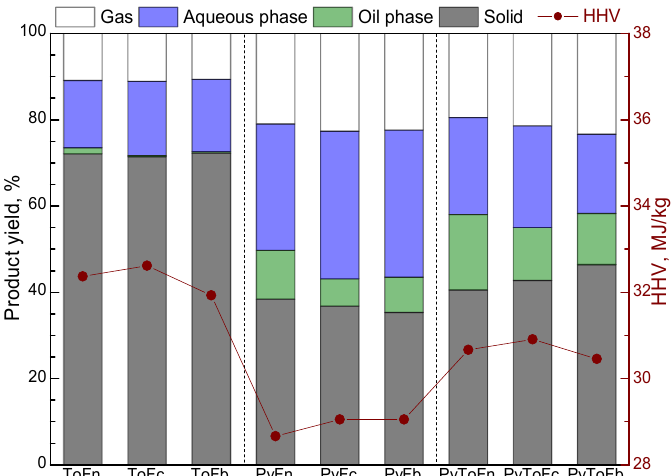
Figure 2. Product yield (±5% associated error) and high heating value (HHV) of solid residues from thermal processing of fir needles, cones and bark by torrefaction and/or pyrolysis. In addition to the product yield, energy aspects should be also considered when deciding on the efficiency of thermal processes. The high heating values of the solid materials were calculated based on the ultimate analysis and are presented in Table 1. Table 1. Proximate ( ± 3% associated error) and ultimate ( ± 5% associated error) analysis (wt%, moisture free basis) of needles, cones and barks from silver fir and of their solids from torrefaction and/or pyrolysis, as well as the related calculated